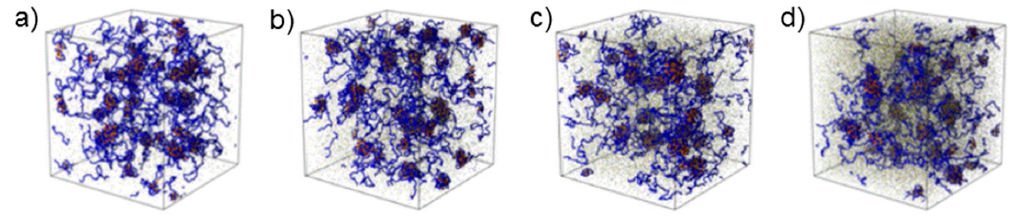
Figure 6. Snapshots from computer simulations of polyampholyte solutions PAA 20 - b -QP2VP 172 - b -PAA 20 (A(QP)A 4 ) at a polymer concentration of 2.2 wt % in salt-free solution ( a ); and at salt concentrations of: 0.153 M ( b ); 0.305 M ( c ); and 0.61 M ( d ). A and QP monomers are shown in orange and blue color, respectively. Reprinted with permission from [35]. Copyright 2015 American Chemical Society.